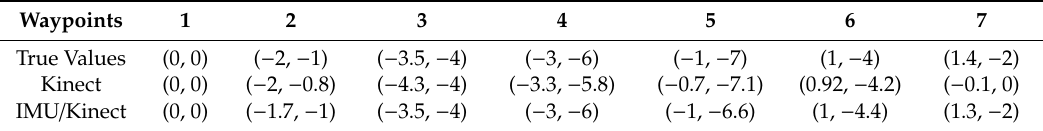
Figure 11. Elliptical track. Table 7. Control points’ coordinates of the elliptical motion experiment (in meters).